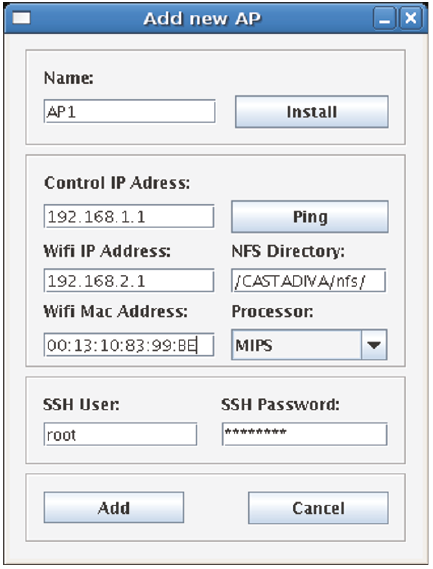
Figure 5: Node configuration